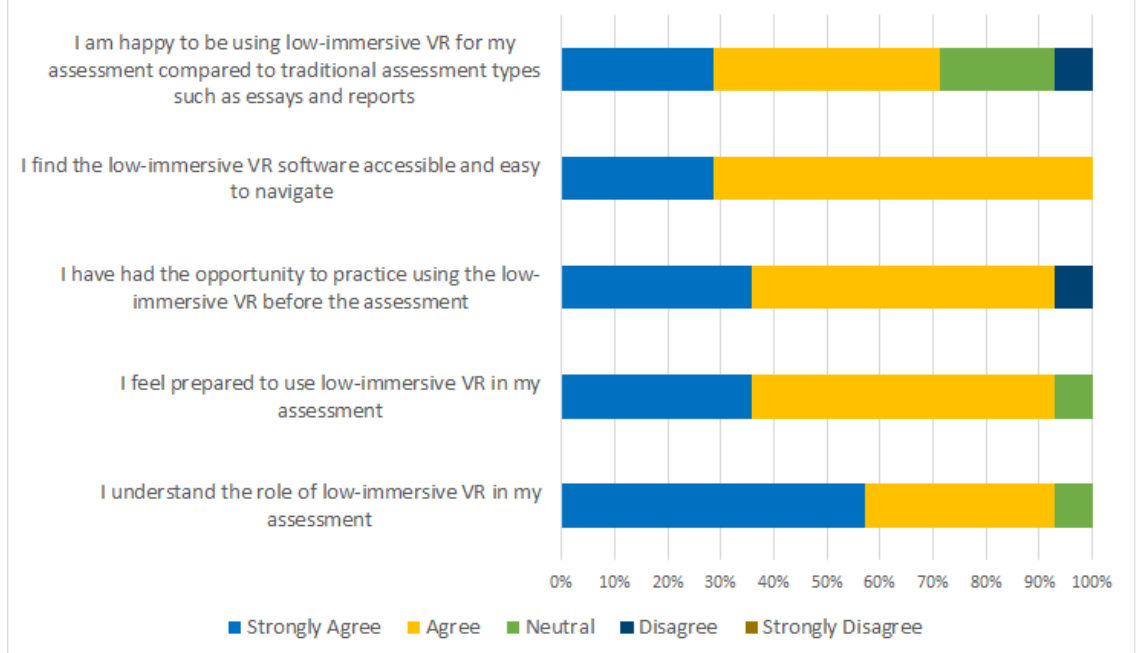
Figure 3 Student Responses on Their Experiences Using the Low-Immersive